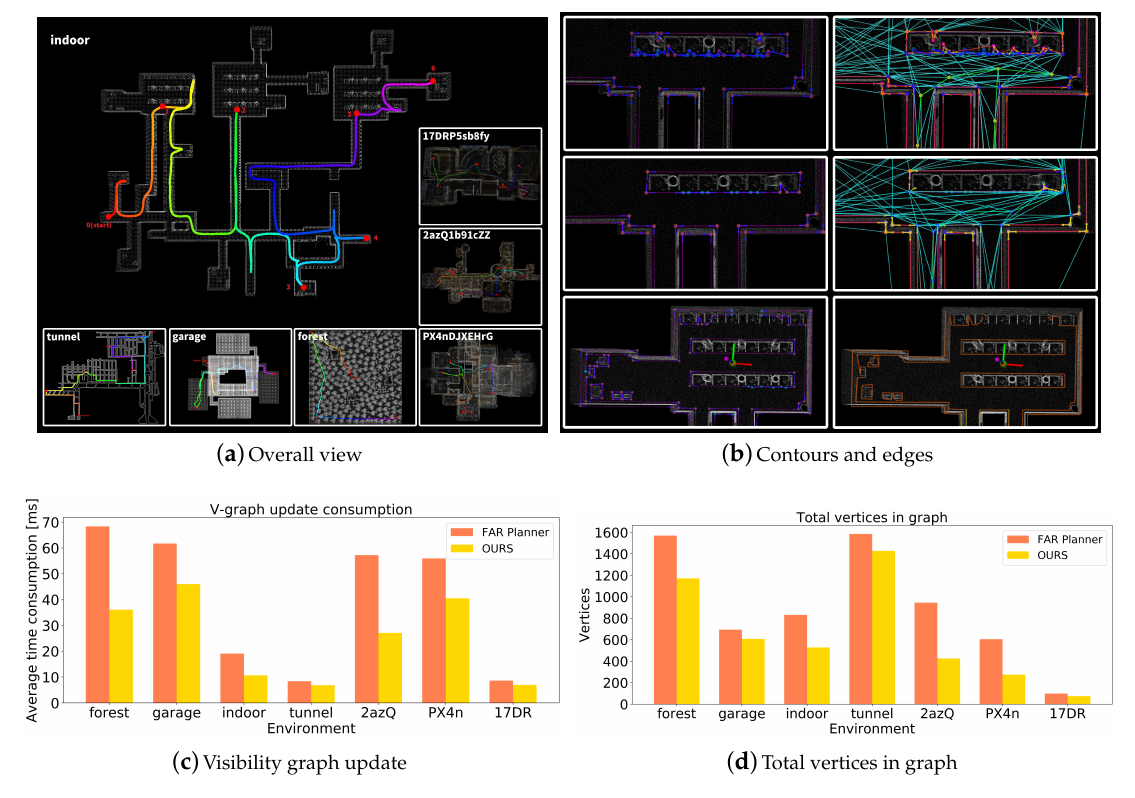
Figure 18. ( a ) shows that the robot runs in different environments and passes through a series of target points. ( b ) shows the geometric outline of obstacles and the connection of edges, red points are valid vertices, and cyan lines represent effective edges. The last one in ( b ) is the optimized global map. ( c ) shows the update speed of our method and the original method in different environments. ( d ) shows the number of vertices in the v-graph after running the same